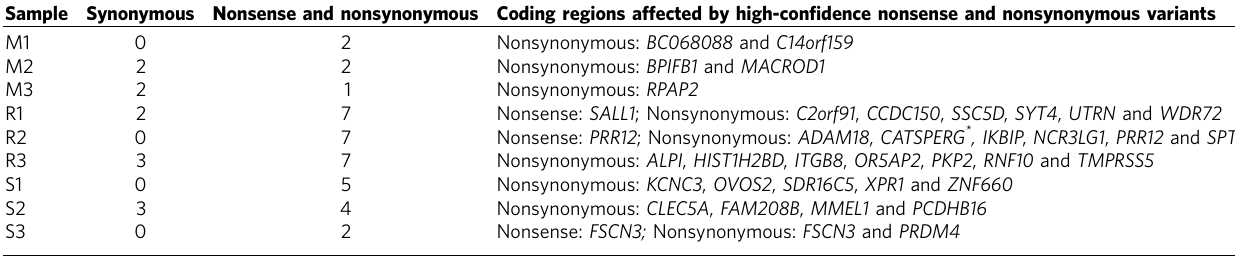
Table 2 | High-confidence variants in coding regions. Number of high-confidence